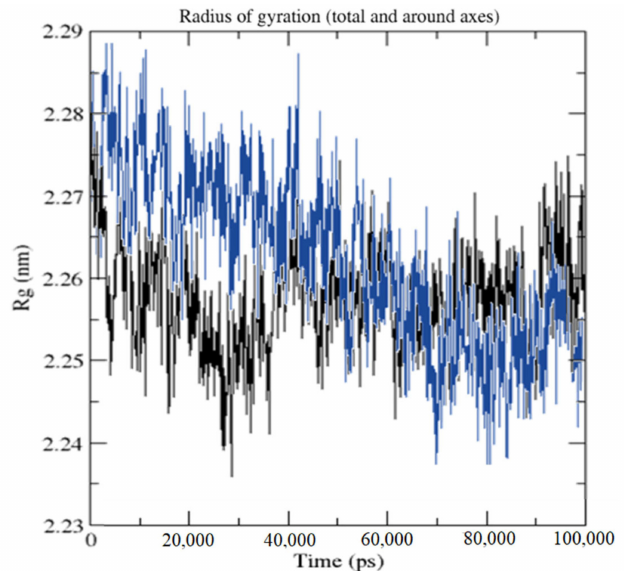
Figure 12. Radius of gyration for HPLD (black) and CTtD complexes (blue) during the 100-ns simulation